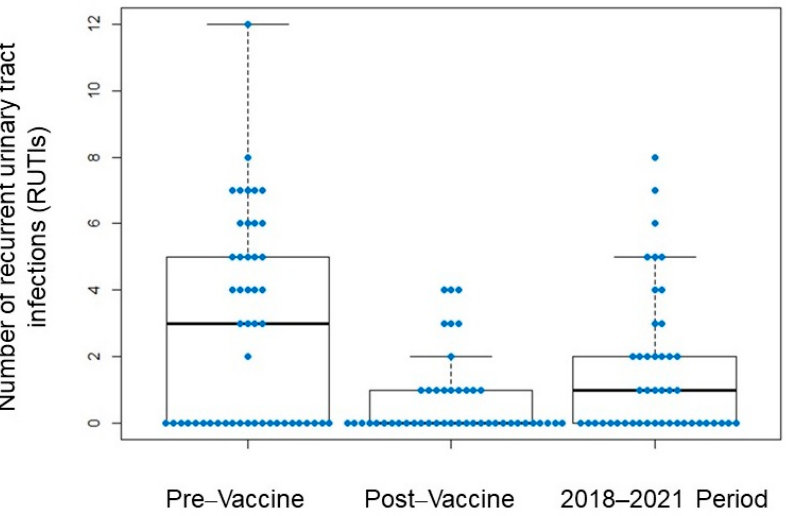
Figure 2. Incidence of recurrent urinary tract infections (RUTIs).